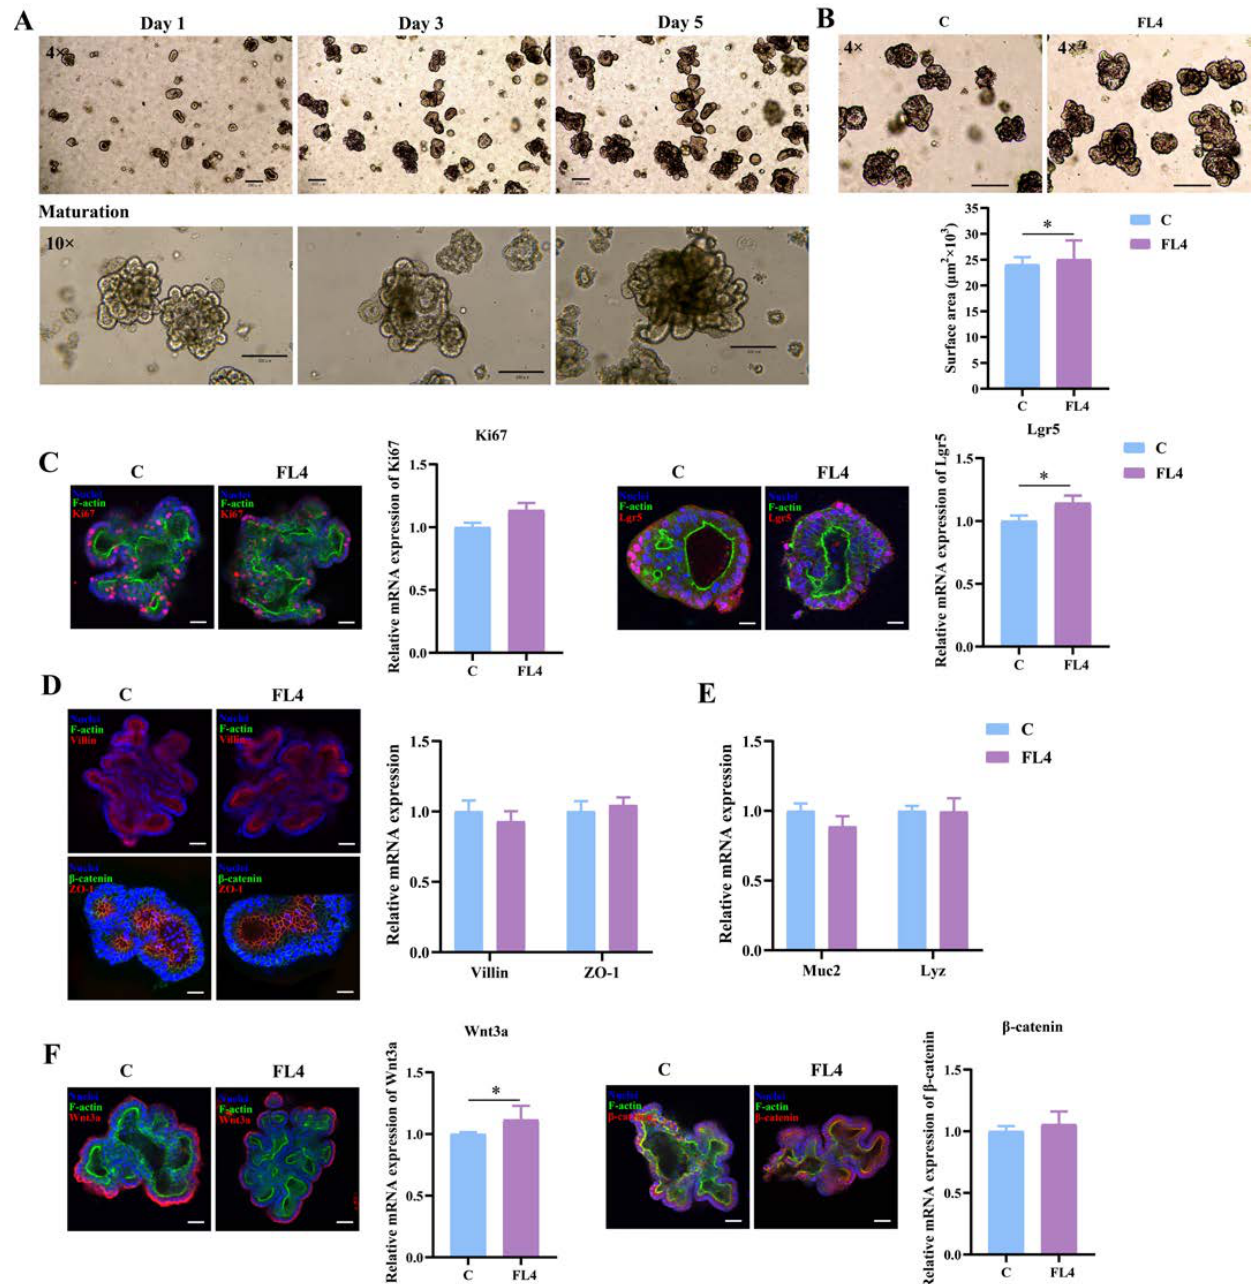
Figure 4. L. fermentum FL4 influenced the proliferation of basal -out intestinal organoids under physiological conditions. ( A ) Resuscitation of cryopreserved intestinal organoids that were passaged at least twice. Morphology of mature intestinal organoids for formal tests. 4×, scale bars, 200 µm; 10×, scale bars, 200 µm. ( B ) Organoids were treated with or without L. fermentum FL4 (10 6 CFU/well) for 24 h. The surface area of organoids was calculated. 4×, scale bars, 200 µm; n = 6. ( C , D ) Confocal images of organoid staining with Nuclei (blue), F-actin (green), Ki67 and Lgr5 (red); scale bars, 20 µm. RT-qPCR analysis of the Ki67 and Lgr5 in organoids treated with/without FL4; n = 3. ( E ) Confocal images of organoid staining with villin and ZO-1 (red); scale bars, 20 µm. RT-qPCR analysis of the villin and ZO-1 in organoids treated with/without FL4; n = 3. ( E ) RT-qPCR analysis of the Muc2, lysozyme (Lyz) in organoids treated with/without FL4; n = 3. ( F ) Confocal images of organoid staining with Wnt3a and β -catenin (red); scale bars, 20 µm. RT-qPCR analysis of the Wnt3a and β -catenin in organoids treated with/without FL4; n = 3. * p < 0.05.